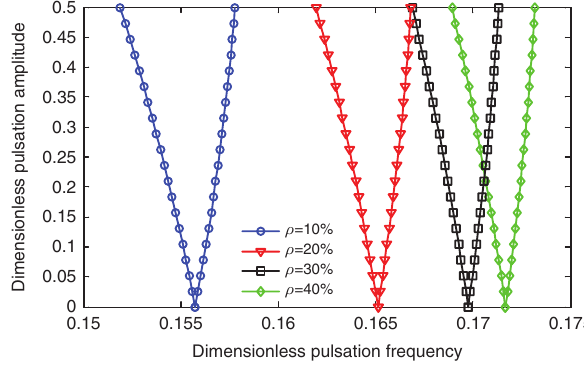
Figure 2: Effect of the volume percent of BNNTs on the dimensionless pulsation amplitude versus dimensionless pulsation